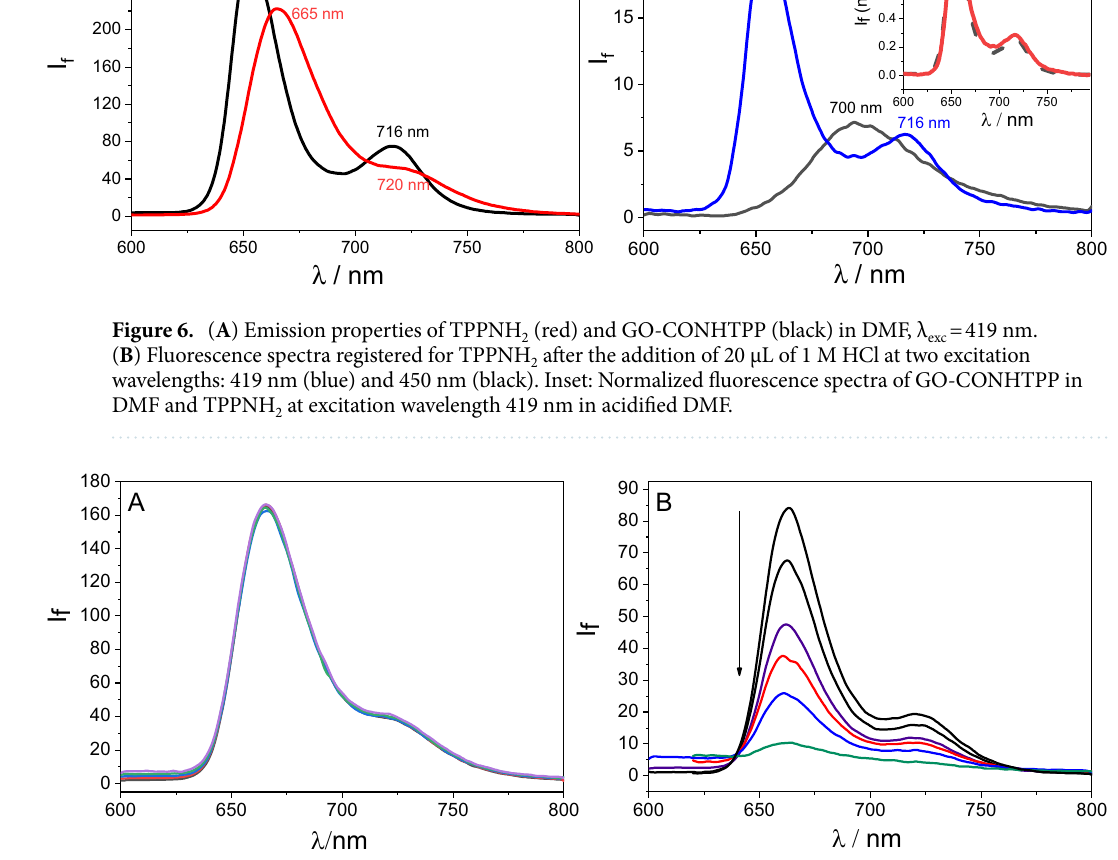
Figure 7. The emission spectra of TPPNH 2 recorded during addition of a suspension of GO (0–0.067 mg mL −1 ). In: ( A ) DMF, λ exc = 419 nm, ( B ) DMF-H 2 O (1:2, v/v), λ exc = 430 nm. Spectra were corrected for the inner filter effects I and